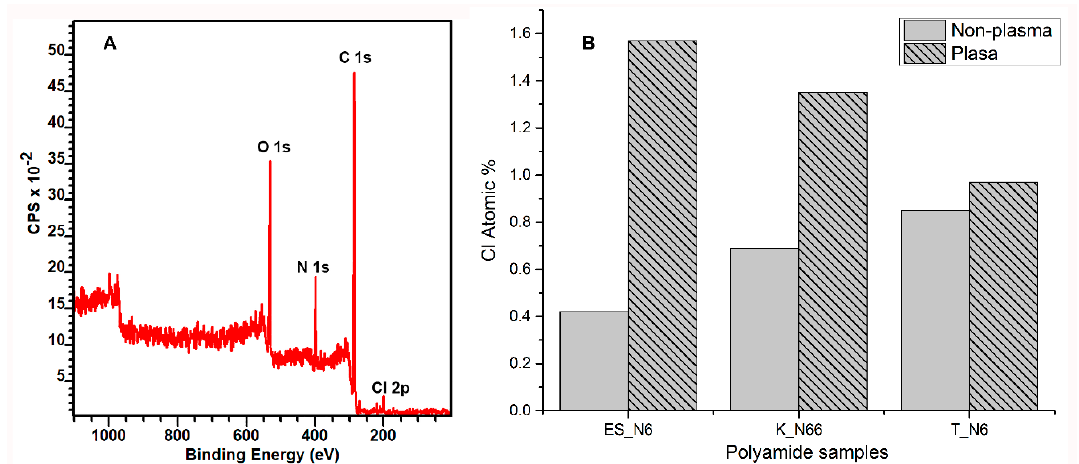
Figure 7. XPS confirmation of the application of permethrin on the polyamide fabrics. ( A ): Survey scan graph of the polyamide samples with permethrin collected at 55° take off angle ( B ): Cl atomic percentage comparison of the untreated and plasma-treated polyamide fabrics.